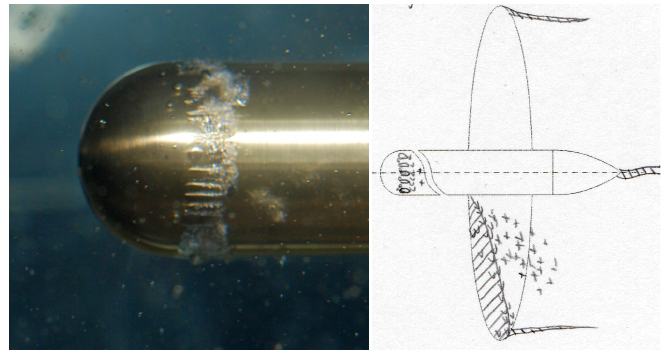
Figure 6. Cavitation extent observed in the experiments with U ∞ = 8 m/s and σ = 0.53. Left picture shows a photograph of the head of the cavitator in the experiments, and right picture shows a sketch of the mean cavitation extent on the cavitator. The pictures are reproduced with permission from Rhena Klose